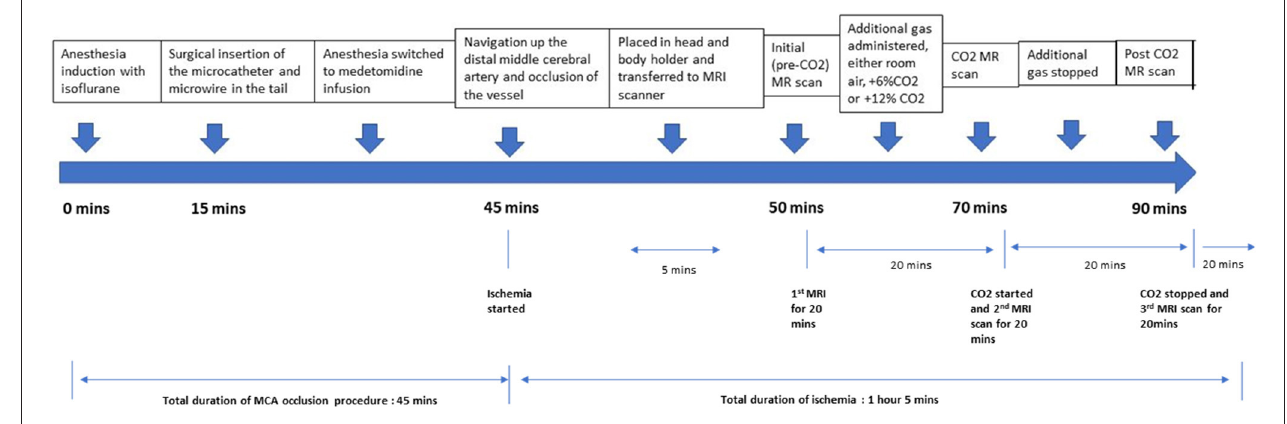
FIGURE 2 | Timeline of the experiment, with approximate timing of each stage of the experiment below.